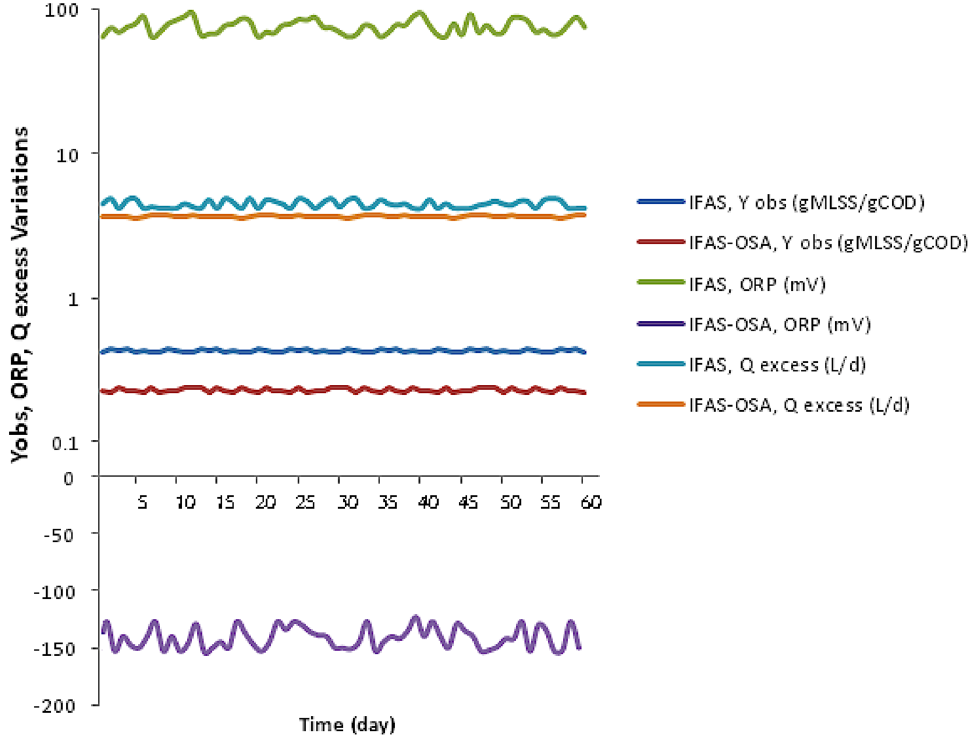
Figure 4. Variations of Y obs , ORP and Q Excess in the effluents of the IFAS and IFAS-OSA systems during the operation